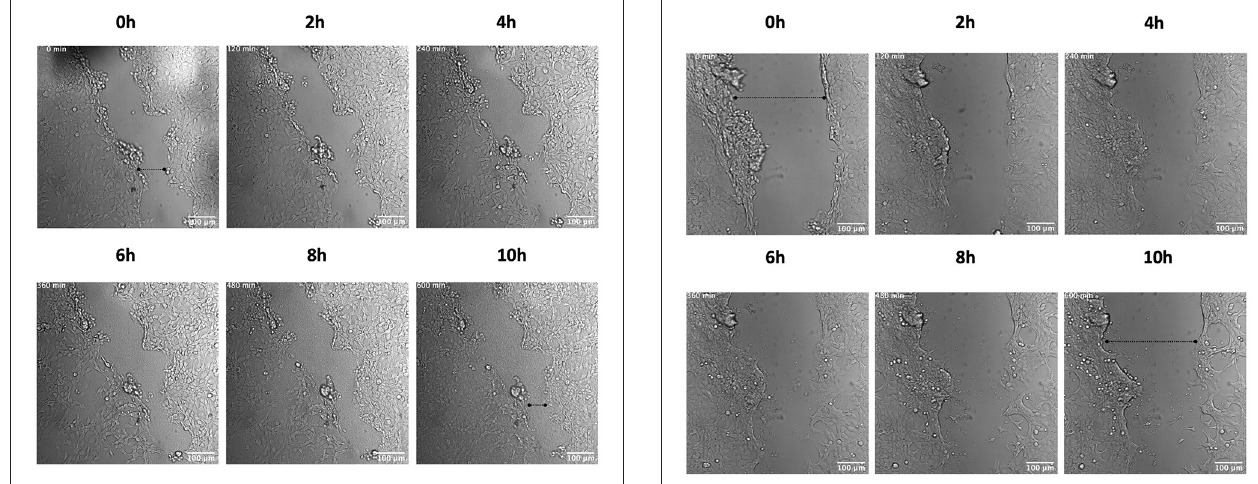
FIGURE 4 | hPg does not cause keratinocyte wound retraction in the absence of GAS. Scratch wounds were produced as in Figure 1 . The cells were then incubated with 7 µ g/ml hPg prior to live imaging. Images were obtained every 10min for 10h for the duration of the imaging experiment. Time-lapsed images of the experiment are shown here (see Supplementary Video 4 ). Dashed lines show the approximate width of wound at the start and end of the